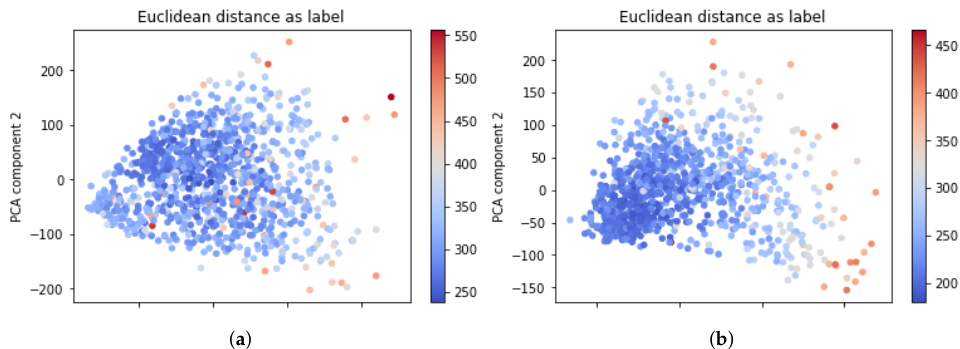
Figure 9. The projection of the feature vectors generated by the PCA algorithm: ( a ) represents the elements from c 0 and ( b ) represents the elements from c 1